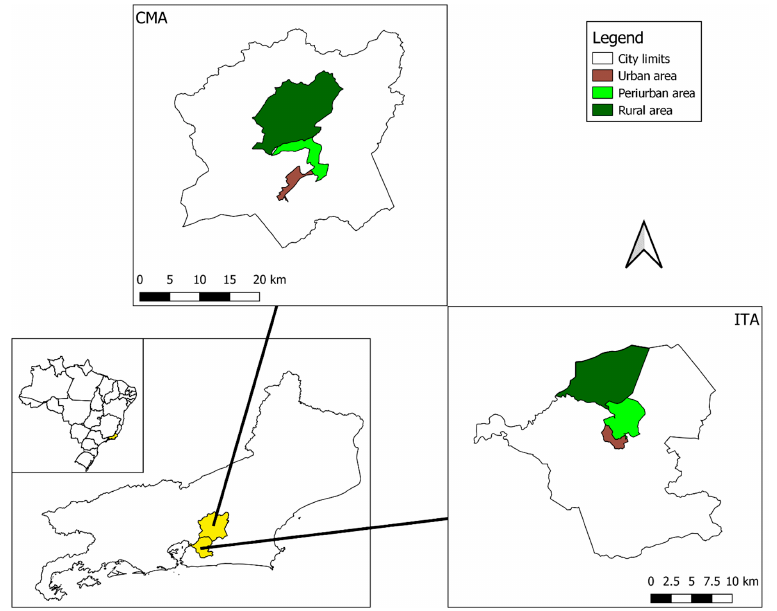
Figure 1. Map of the state of Rio de Janeiro showing the location of Cachoeiras de Macacu (CMA) and Itaboraí (ITA). Collection areas comprise one or more neighborhoods and are divided into urban (brown), peri-urban (light green), and rural (dark green).